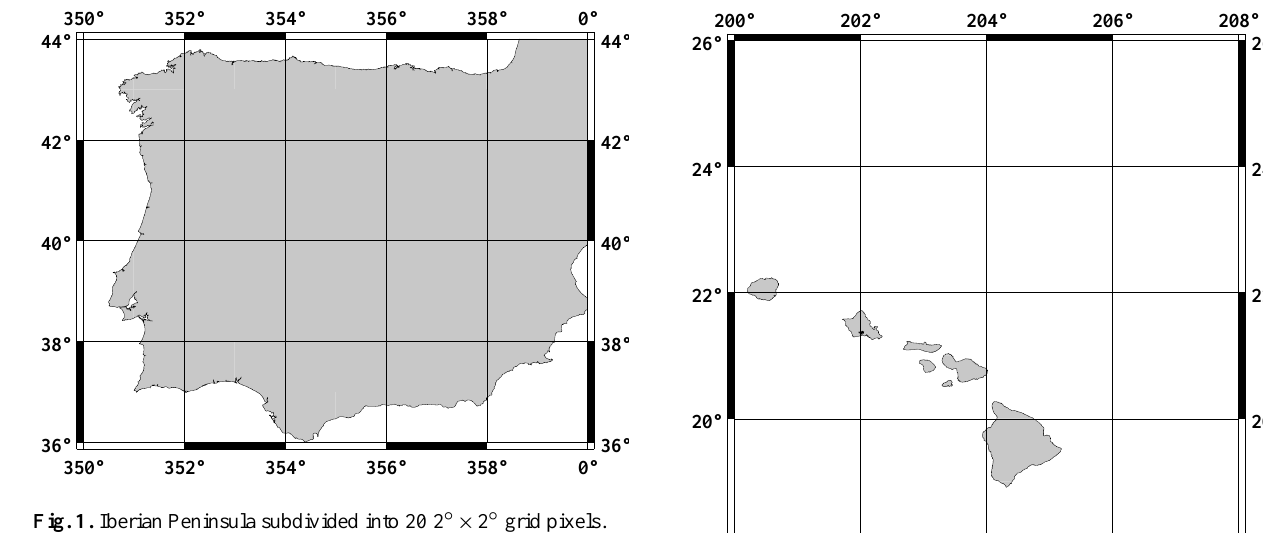
Fig. 1. Iberian Peninsula subdivided into 20 2 ◦ × 2 ◦ grid pixels.